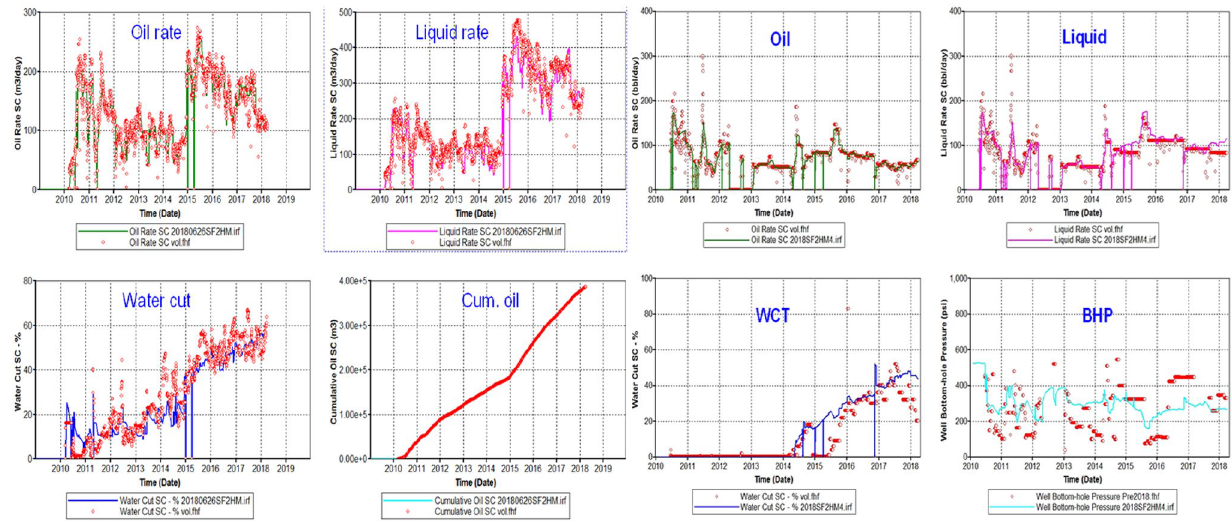
Fig. 5 History matching result of block and single well Fig. 6 Flood patterns